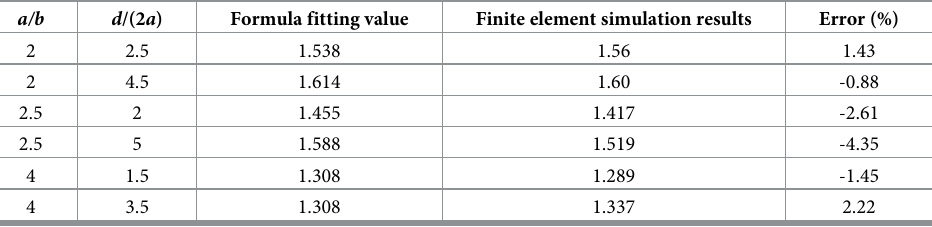
Table 2. The fitting error of empirical formula for